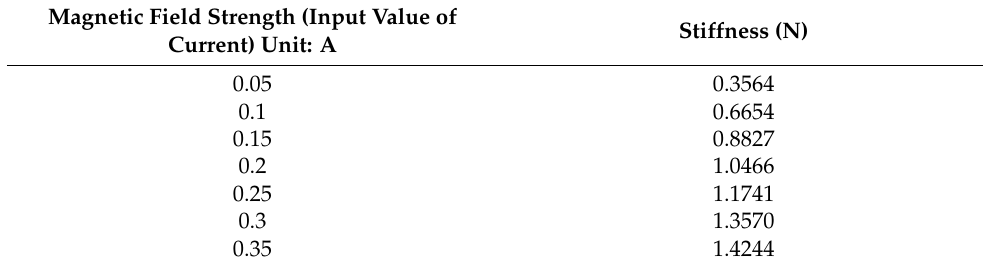
Figure 11. Elastic modulus of various types of human tissues [48, 49]. Table 3. Calculated stiffness of human tissues from the elastic modulus.